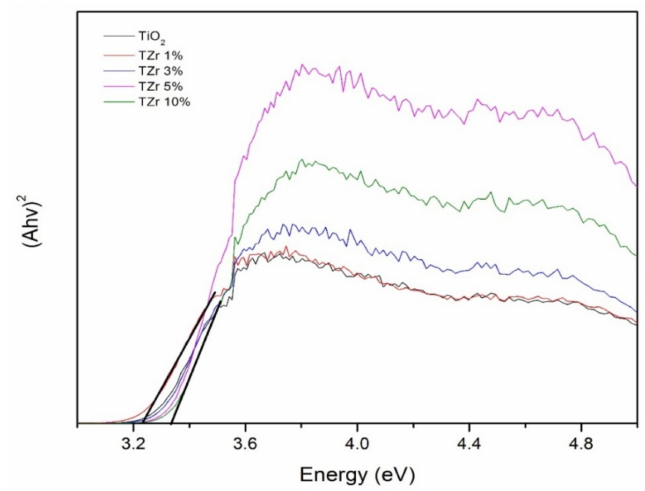
Figure 5. Determination of the band gap energies for TiO 2 and Ti–Zr